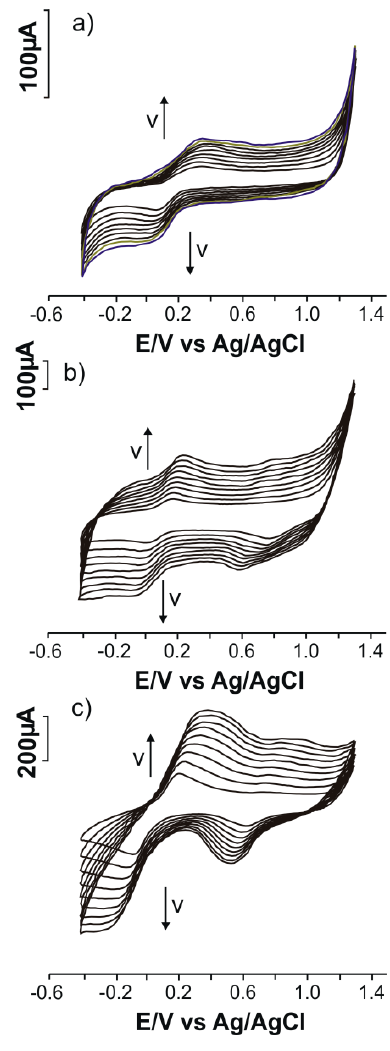
Figure 2. Cyclic voltammograms obtained with the three modified SPCEs immersed in 10 − 3 M K 4 [Fe(CN) 6 ]–10 − 1 M KCl solution with scan rates in the range 0.1–1.0 V × s − 1 : ( a ) CoPc-SPCE; ( b ) MB-SPCE; ( c ) PB-SPCE.